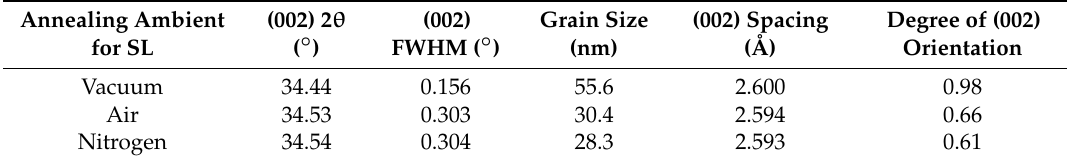
Table 2. Parameters of the ZnO SL crystals extracted by XRD